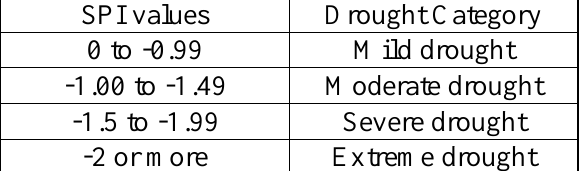
Table 1: Standard precipitation index categories [5].